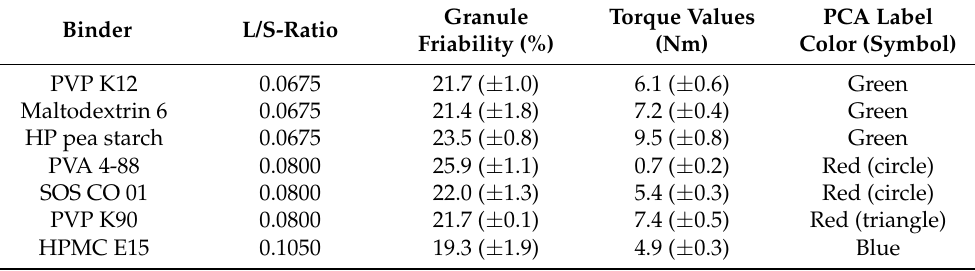
Figure 3. Friability of granules as a function of L/S-ratioand binder type for the mannitol formulation. The granule friability obtained with pure mannitol is also illustrated (pink diamond). The granule friability limit of 30% is illustrated with the dotted line, representing the limit to identify sufficiently strong granules. Table 3. Binders with corresponding L/S-ratio needed to obtain the granule friability limit (<30%), with granule friability and torque values obtained at this L/S-ratio, and with the color assigned on the PCA score plot (PCA_2).